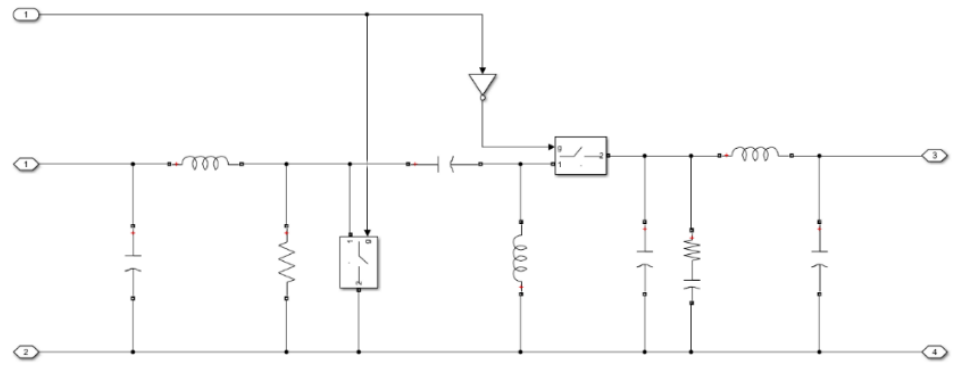
Figure 11. Submodel block for the SEPIC converters.